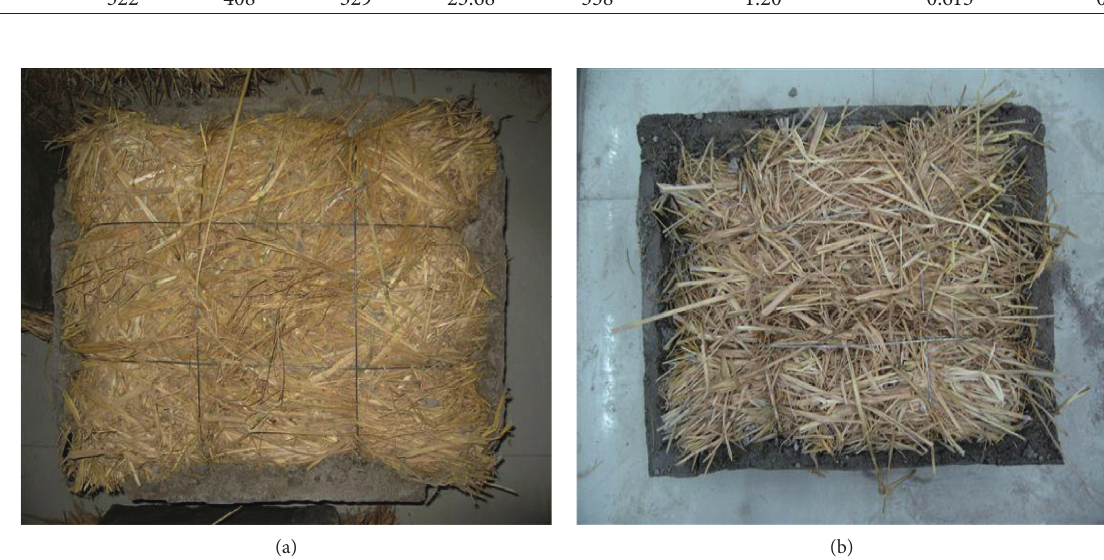
Figure 3: Plastered straw bales. (a) Straw bales with incomplete plaster (no plaster on the corners). (b) Straw bales with complete plaster.